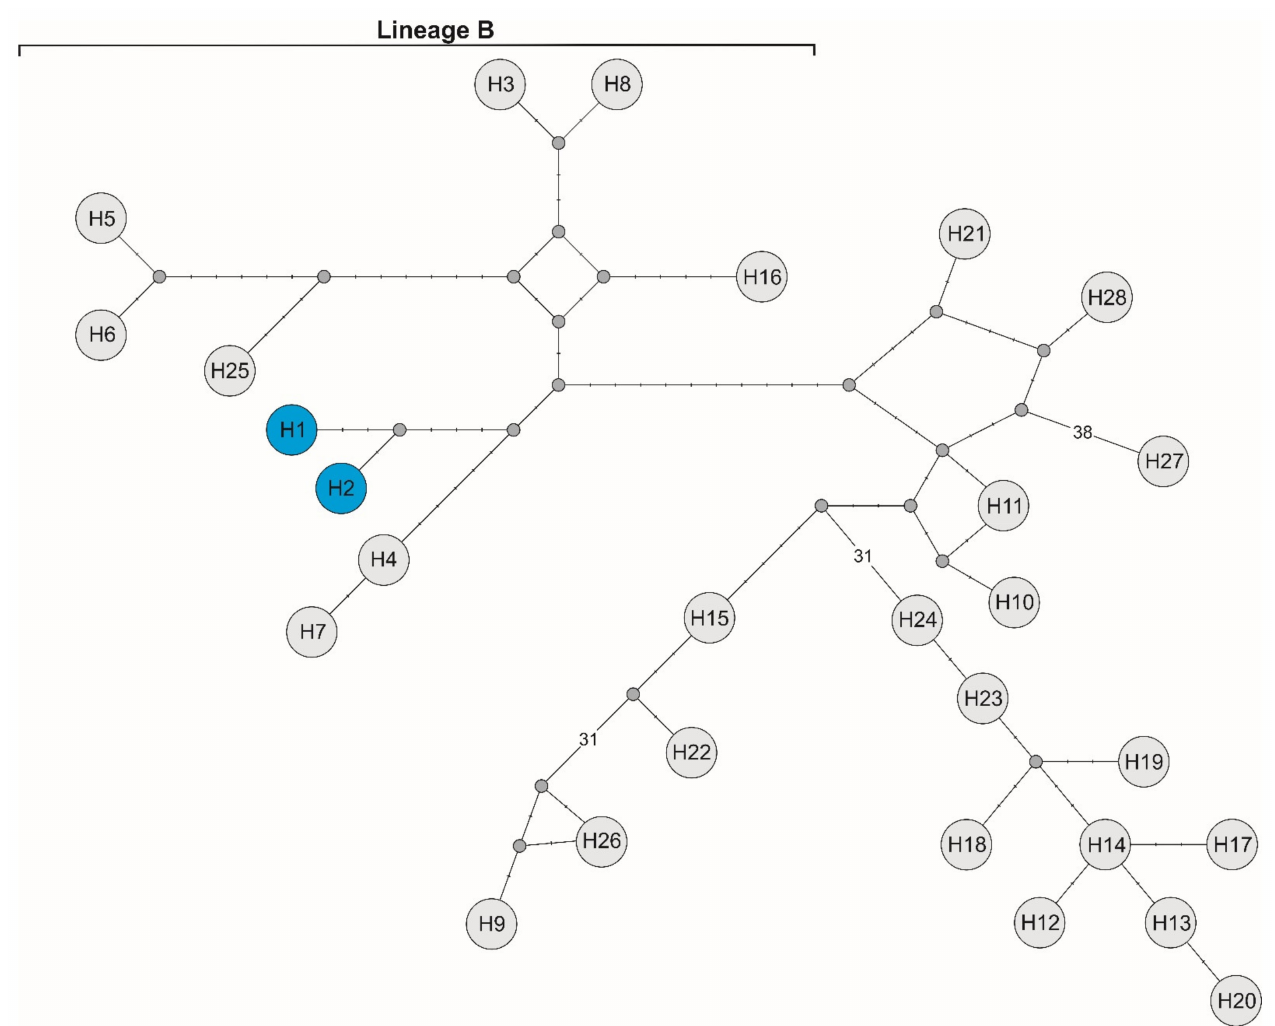
Figure 3. Median-joining network of rpo B haplotypes from Poland (H1 and H2, marked with a blue background) and haplotypes of different Bartonella species obtained from GenBank (H3–H28, symbols according to Table 1). Missing haplotypes are indicated by a grey